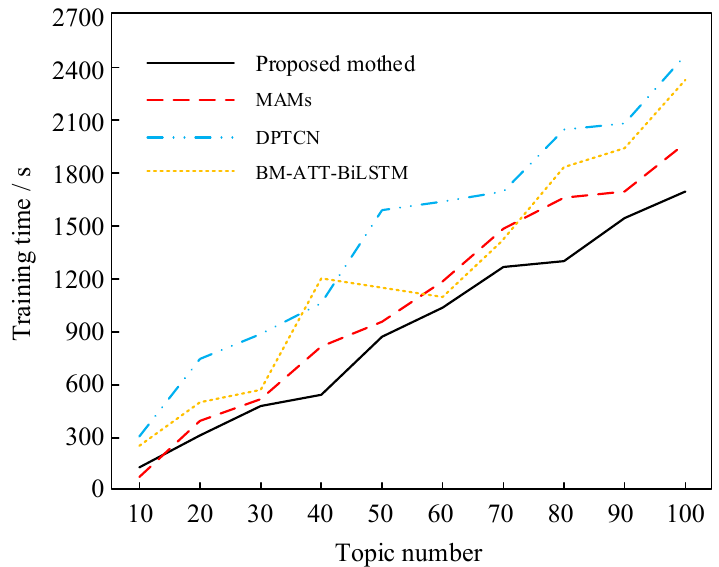
Figure 11. Training time of different methods under SCP dataset.